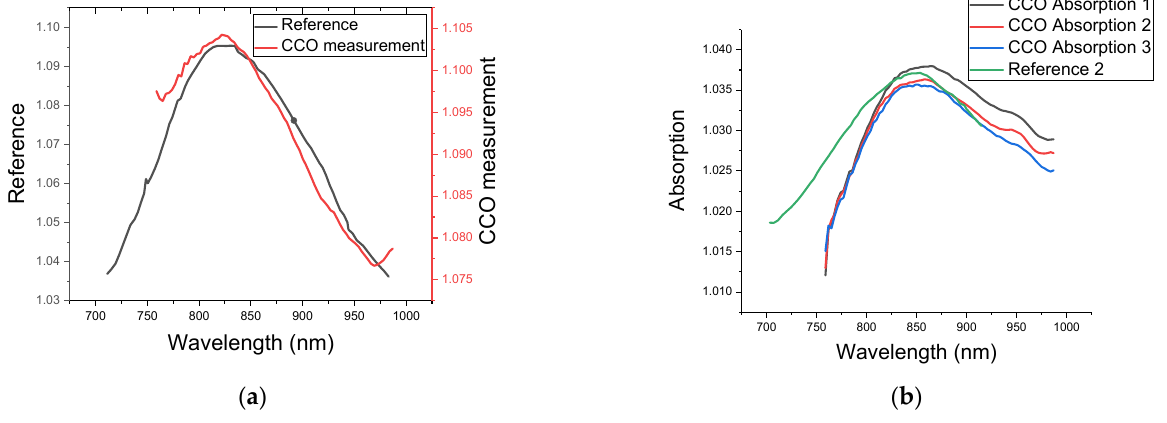
Figure 4. ( a ) Laboratory measurement of purified CCO in set-up of Figure 1. The red curve is our measurement, while the black curve is reported in the literature [35]. ( b ) CCO is seen to shift slightly when measured over a period of time with the cuvette lid closed. The CCO absorption might be a function of different CCO groups and states.